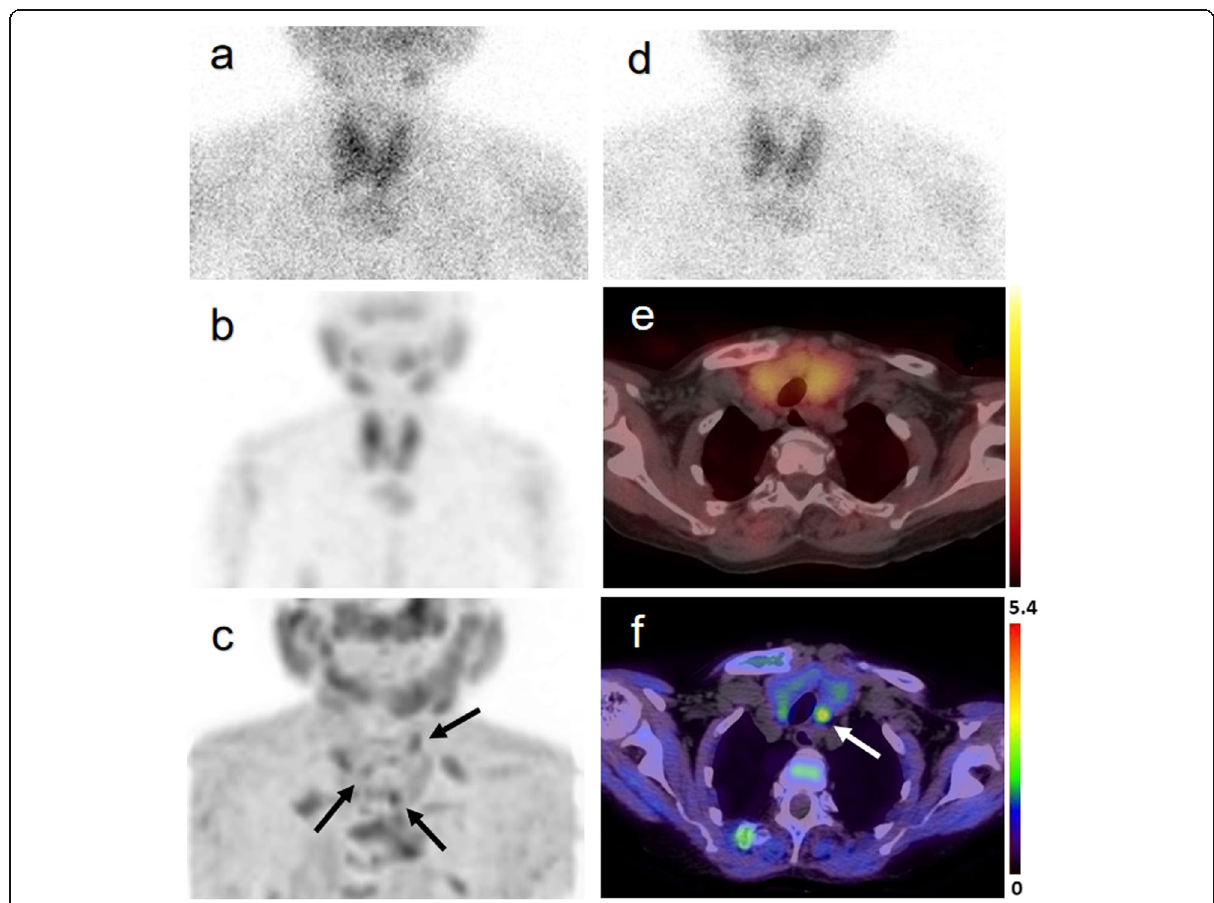
Fig. 1 Images of a 62-year-old woman (case 11) with three parathyroid hyperplastic lesions. The early ( a ) and late ( d ) planar 99m Tc-sestaMIBI SPECT/CT images, MIP (maximum intensity projection) images of 99m Tc-sestaMIBI SPECT/CT ( b ), and fusion image ( e ) cannot present all three lesions clearly because of Hashimoto ’ s thyroiditis. Although the MIP image of 18 F-FCH PET ( c ) is unclear due to renal osteopathy, the lesion is visible in the image (arrows). An 18 F-FCH PET/CT fusion image ( f ) shows homogeneous tracer uptake behind the left lobe of the thyroid gland (arrow)